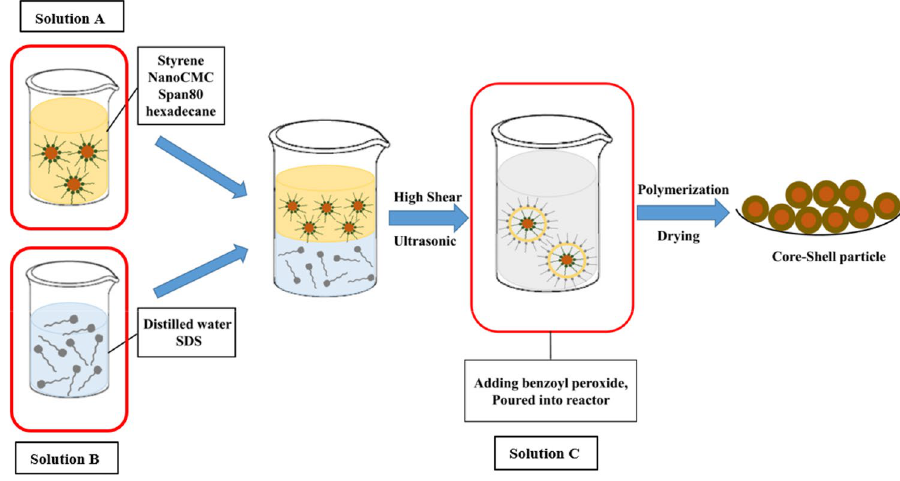
Fig. 3 Schematic of